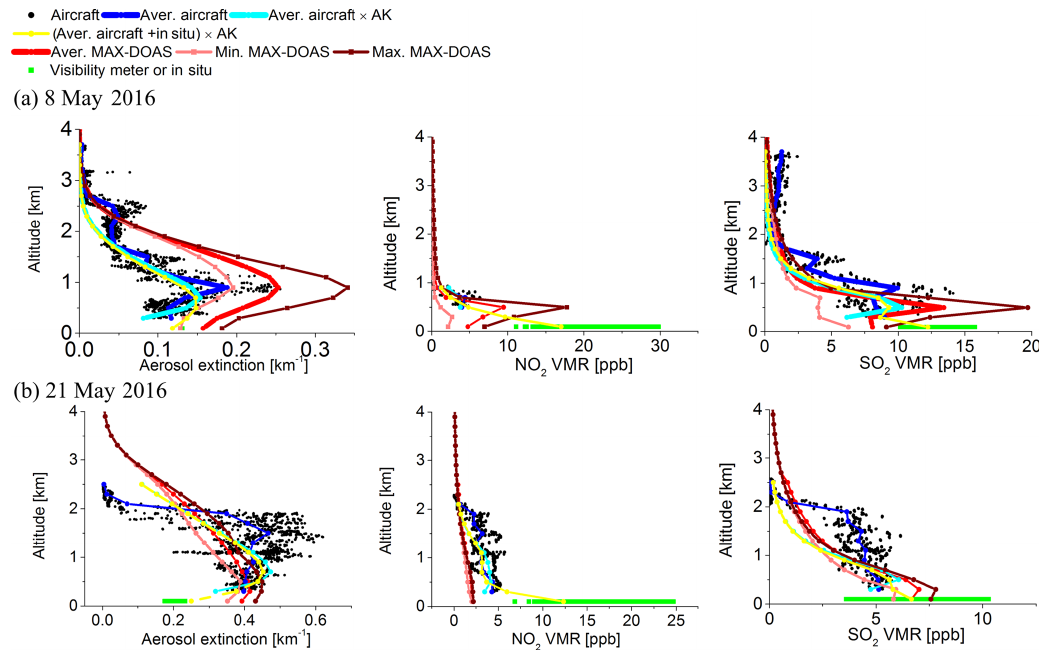
Figure 8. Vertical profiles of aerosol extinction, and VMRs of NO 2 and SO 2 derived from the MAX-DOAS measurements compared with corresponding aircraft measurements on 8 May 2016 (a) and 21 May 2016 (b) . The black dots represent the original aircraft measurements. The light and dark blue curves show the averaged and smoothed (with the averaging kernels) aircraft data. The red, pink and brown lines indicate the averaged, maximum and minimum profiles derived from the MAX-DOAS measurements during the overpass time of the aircraft measurements. The near-surface values from the visibility meter and in situ trace gas measurements are indicated by the green dots. The yellow curves show the averaged and smoothed combined profiles from aircraft and surface